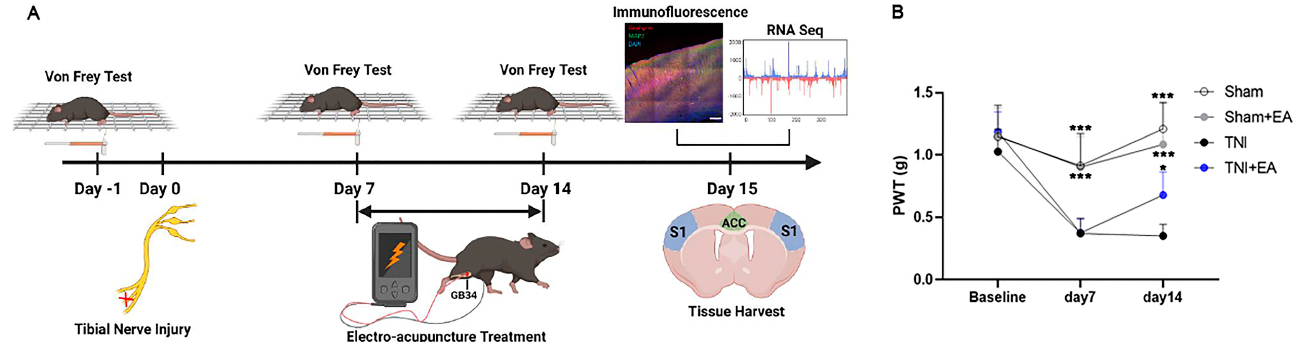
Figure 1. ( A ) A schematic illustration of the overall experimental design. ( B ) EA improved allodynia in TNI mice. TNI-induced PWT reduction was improved by EA treatment, while EA did not a ff ect the pain threshold in sham mice (error bars are for standard deviations (same for the following fi gures); *, ***: p < 0.05, 0.001 compared with TNI group, respectively; two-way ANOVA followed by Bonferroni post hoc tests; n = 5 −